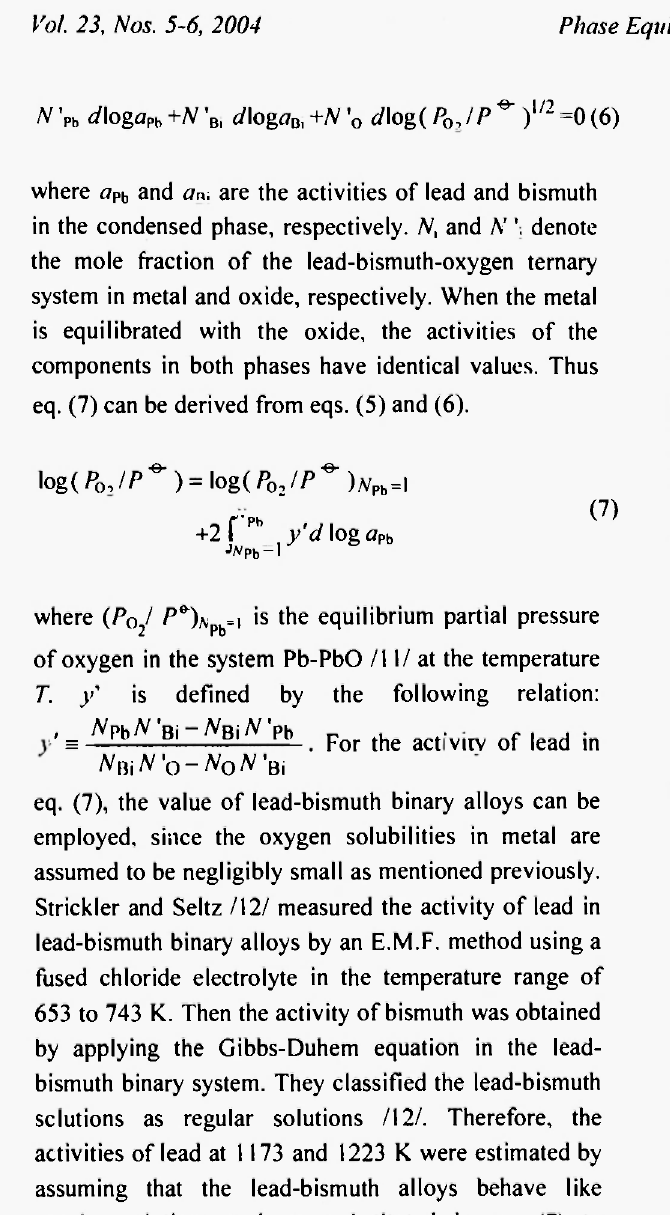
Fig. 8: Relation between the partial pressure of oxygen and the composition of condensed phase in the lead-bismuth-oxygen system at 1173 and 1223 K, where X a ,=N Bi /(N n +N Rl ): molar ratio in metal. X ' Bl =/V ' B ,/(/V ' Pb +N ' Bj ): molar ratio in oxide, Ο Δ: oxide phase, · A: metal